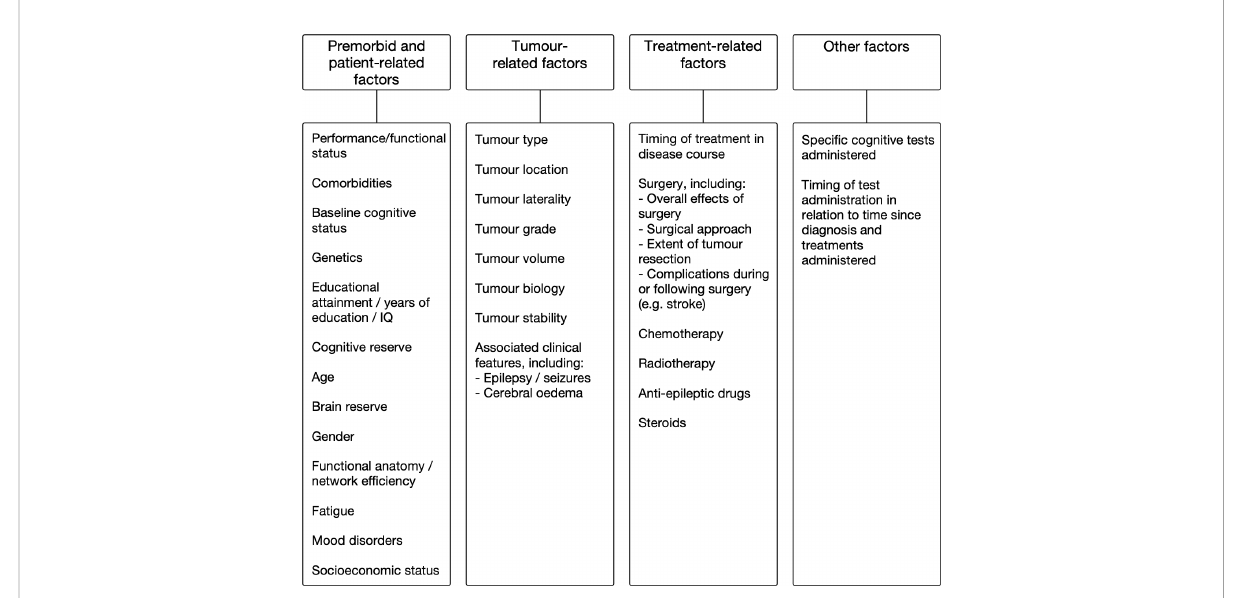
FIGURE 2 Potential factors associated with cognitive dysfunction in patients with